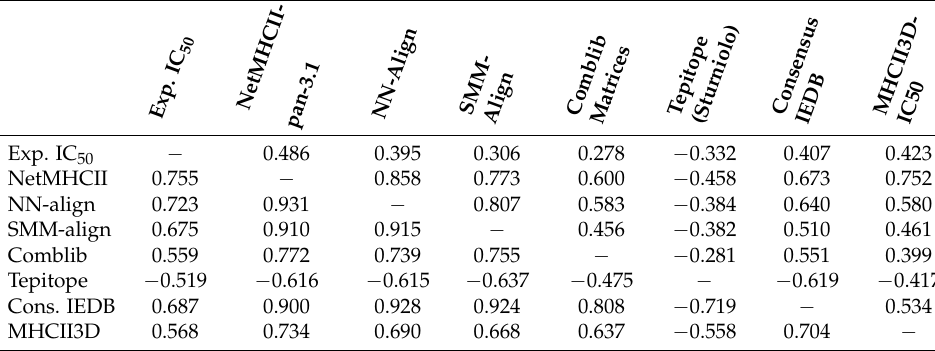
Table 4. Correlations between prediction methods and experimentally determined IC 50 values, respectively. Based on 1078 of 13,339 entries provided by IEDB weekly benchmarks (31 December 2016–22 March 2019). Upper triangle: Pearson correlation coefficient; lower triangle: Spearman’s rank correlation